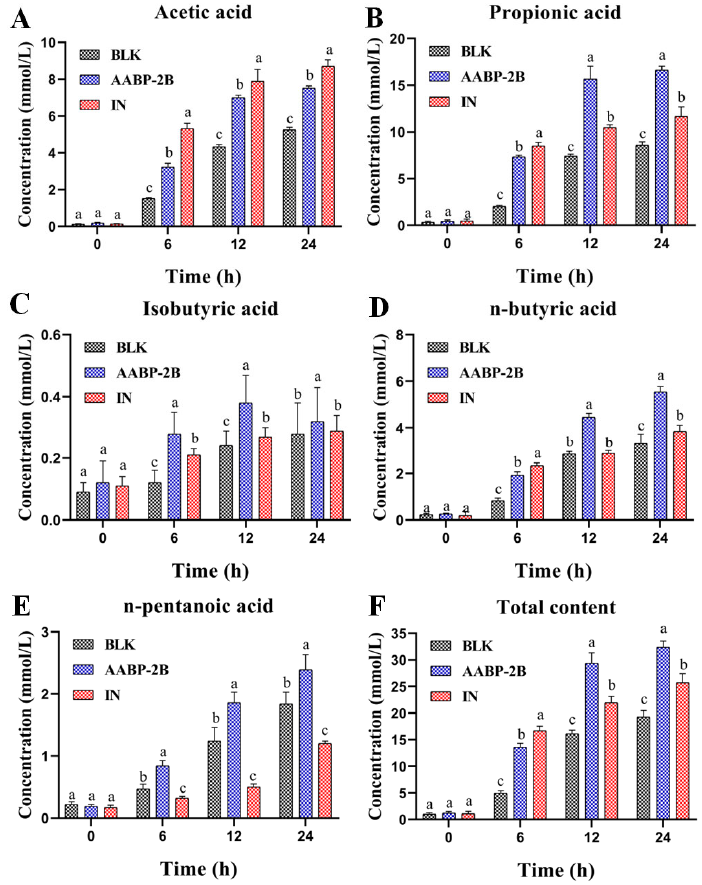
Figure 6. SCFA concentrations of AABP-2B during fermentation: ( A ) acetic acid; ( B ) propionic acid; ( C ) isobutyric acid; ( D ) n -butyric acid; ( E ) n -pentanoic acid; and ( F ) total content. Statistically significant di ff erences were observed between di ff erent le tt ers ( p < 0.05).